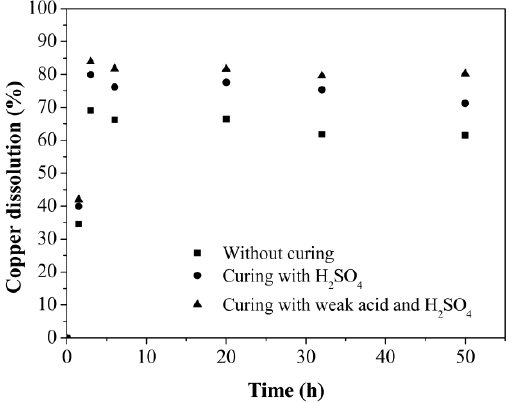
Figure 5. Copper leaching test with weak acid and water as a leaching agent.